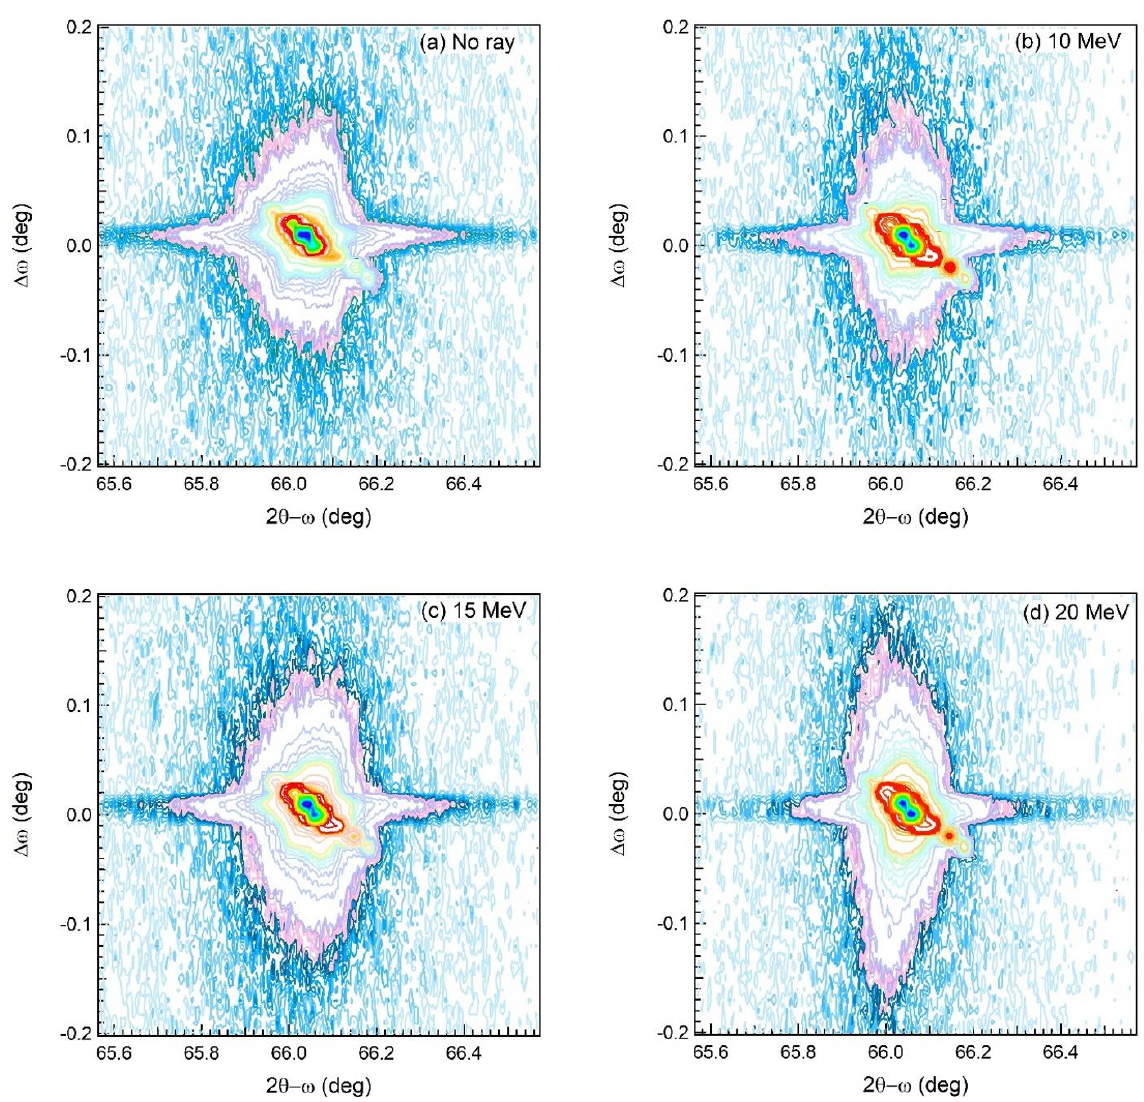
Figure 7. Symmetric (004 ) RSM of the non - irradiated GaAs ( a ), the irradiated GaAs at the highest irradiation dose of 2.0 MGy at an electron energy of ( b ) 10; ( c ) 15; and ( d ) 20 MeV.